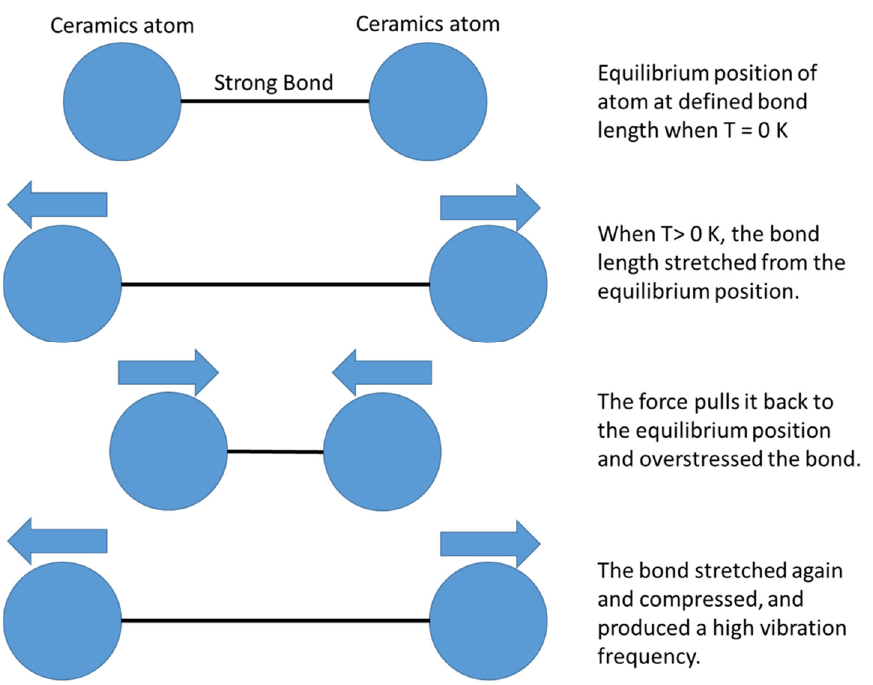
Figure 15. Analogy diagram of high-frequency bond vibrations on how ceramics gain high thermal capacity. Table 9. Thermal properties of